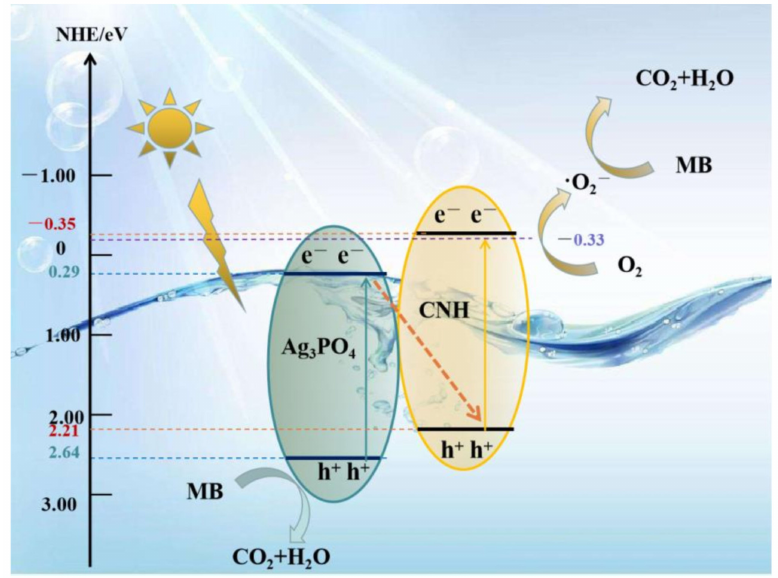
Figure 10. Possible photocatalytic mechanism for the degradation of MB over Ag/CNH(III).